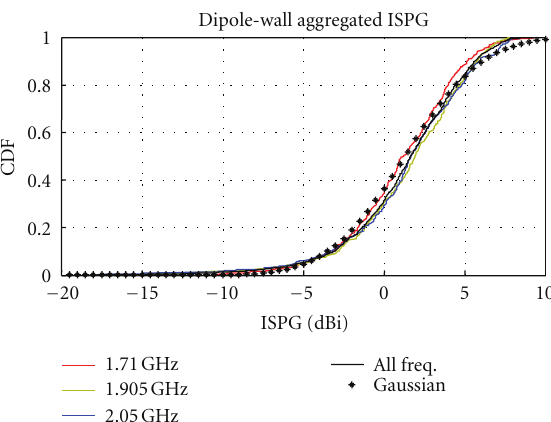
Figure 16: ISPG distribution for these two